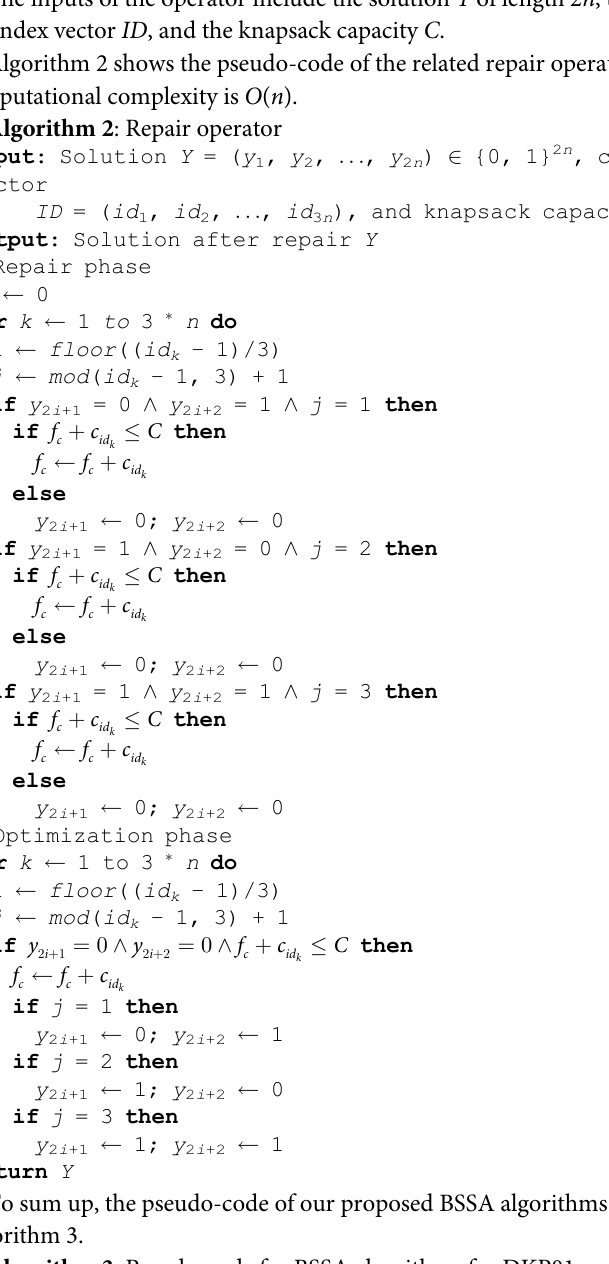
Algorithm 3 : Pseudo-code for BSSA algorithms for